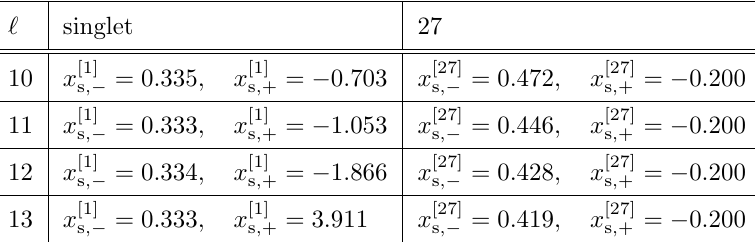
Table 1 . Table summarising the values of x = (cid:11) s L at the poles of the Pad(cid:19)e Approximants in (cid:25) eq. (6.16), considering the soft component of the infrared-renormalized amplitude (indicated by the subscript s) at orders ‘ = 10 through 13 for the singlet and the 27